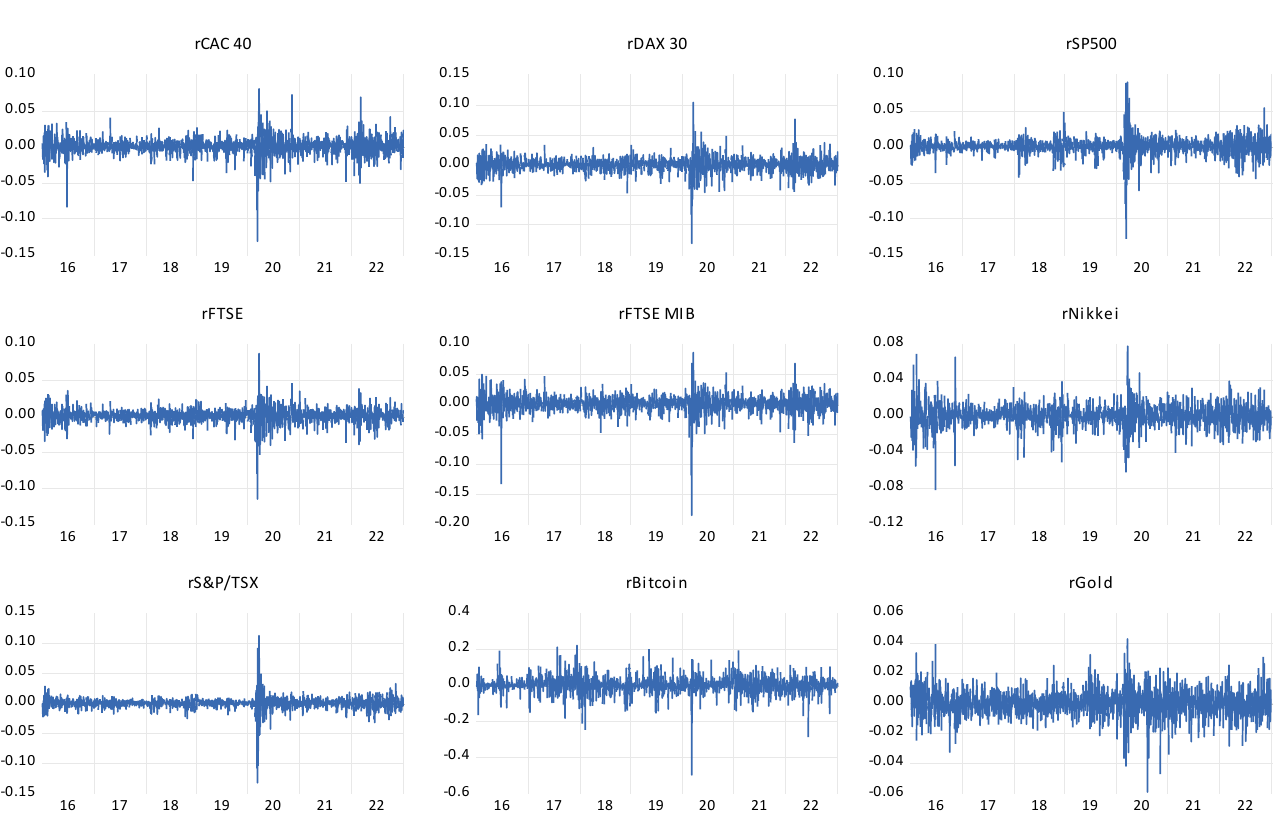
Figure 1. Daily return index dynamics regarding the entire period.